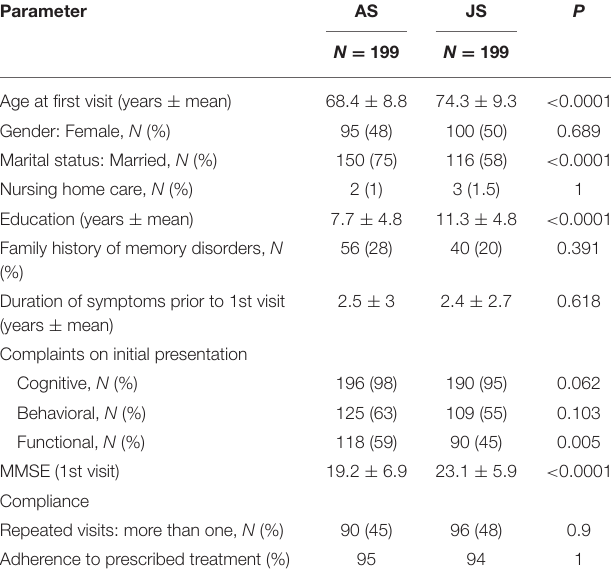
Mean age at first visit was 68.4 ± 8.8 for AS and 74.3 ± 9.3 years for JS ( p < 0.0001). Mean education was 7.7 ± 4.8 years